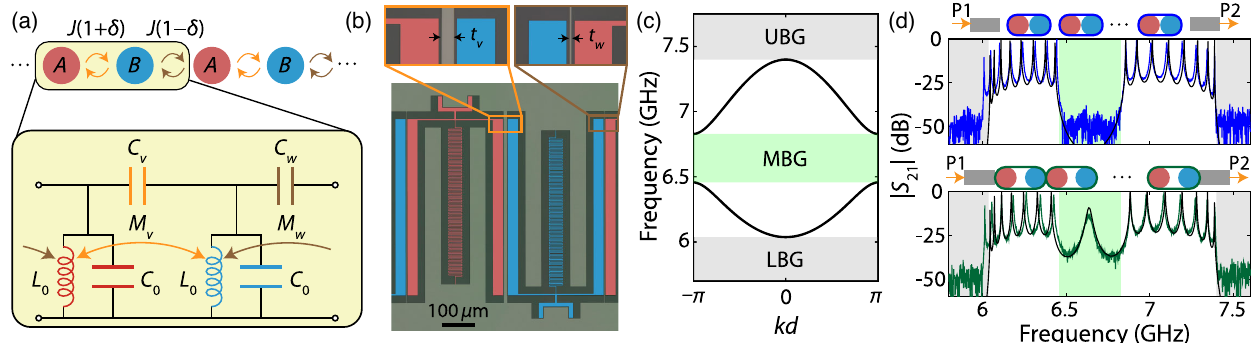
FIG. 1. Topological waveguide. (a) Top: schematic of the SSH model. Each unit cell contains two sites A and B (red and blue circles) with intracell and intercell coupling J ð 1 (cid:4) δ Þ (orange and brown arrows). Bottom: an analog of this model in electrical circuits, with corresponding components color coded. The photonic sites are mapped to LC resonators with inductance L 0 and capacitance C 0 , with intracell and intercell coupling capacitance C , C and mutual inductance M , M between neighboring resonators, respectively v w v w (arrows). (b) Optical micrograph (false colored) of a unit cell (lattice constant d ¼ 592 μ m) on a fabricated device in the topological phase. The lumped-element resonator corresponding to sublattice A ( B ) is colored in red (blue). The insets show enlarged view of the 10 ; 2 Þ μ m (indicated with black arrows) control the intracell and ; t section between resonators where planar wires of thickness ð t v w Þ ¼ ð intercell distance between neighboring resonators, respectively. (c) Dispersion relation of the realized waveguide according to the circuit model in (a). Upper band gap (UBG) and lower band gap (LBG) are shaded in gray, and middle band gap (MBG) is shaded in green. (d) Waveguide transmission spectrum j S 21 j across the test structure with 8 unit cells in the trivial ( δ > 0 , top) and topological ( δ < 0 , bottom) phase. The cartoons illustrate the measurement configuration of systems with external ports 1 and 2 (denoted P1 and P2), where distances between circles are used to specify relative coupling strengths between sites and blue (green) outlines enclosing two circles indicate unit cells in the trivial (topological) phase. Black solid curves are fits to the measured data (see the Appendix A for details) 33 ; 17 Þ fF and mutual inductance ð M ; C ; M with parameters L 0 ¼ 1 . 9 nH, C 0 ¼ 253 fF, coupling capacitance ð C v w Þ ¼ ð v w Þ ¼ ð − 38 ; − 32 Þ pH in the trivial phase (the values are interchanged in the case of topological phase). The shaded regions correspond to band gaps in the dispersion relation of